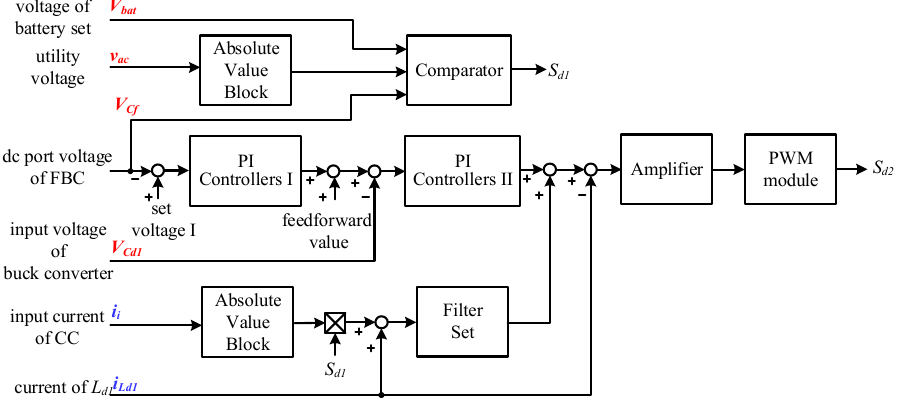
Figure 8. Control block of the proposed DIBC.